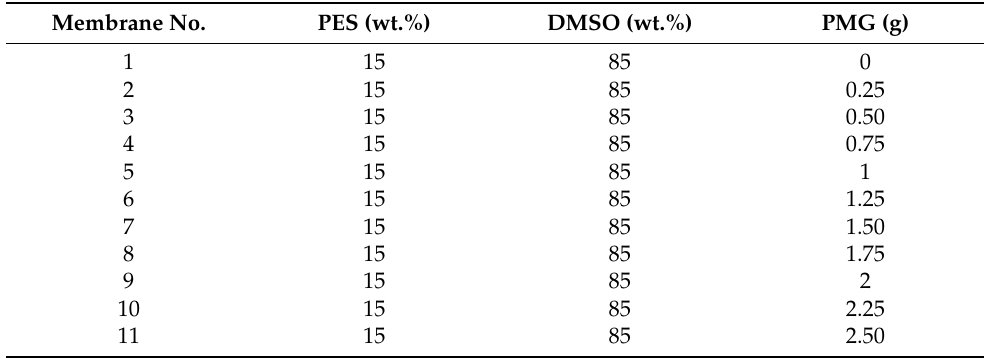
Table 1. Composition of PMG/PES UF membranes. Membrane